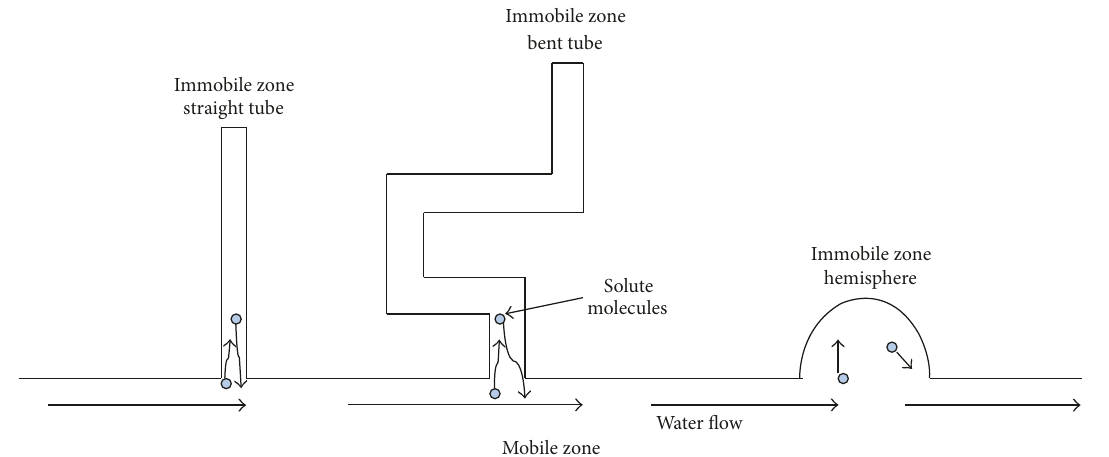
Figure 1: The schematic diagram of mobile zone and immobile zone. Three types of dead-end pores, that is, straight tube, bent tube, and hemisphere, represent the immobile